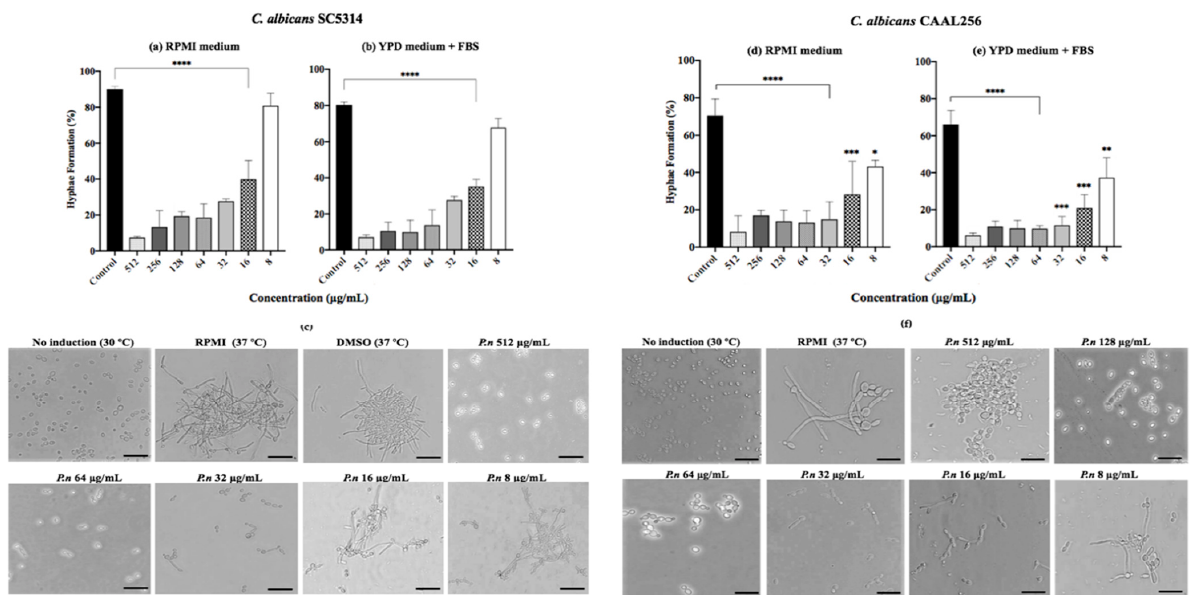
Figure 3. Effect of P. nigrum ethanolic extract treatment on yeast to hyphal transition. Percentage of filamentation in C. albicans ( a , b ) SC5314 and ( d , e ) CAAL256 strains, photographic record of ( c ) SC5314 ( f ) CAAL256. The scale at the bottom right of the images represents 50 µm. p -values of <0.05 were used to indicate statistical significance as follows: * p ≤ 0.05. ** p ≤ 0.01. *** p ≤ 0.001. **** p ≤ 0.0001.